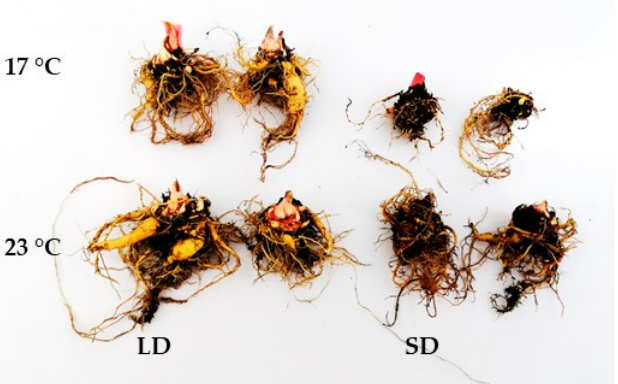
Figure 3. The effect of temperature (17 °C and 23 °C) and photoperiod (LD—long day, SD—short day) on rhizome growth of rhubarb plantlets after three months of growth in the growth room.